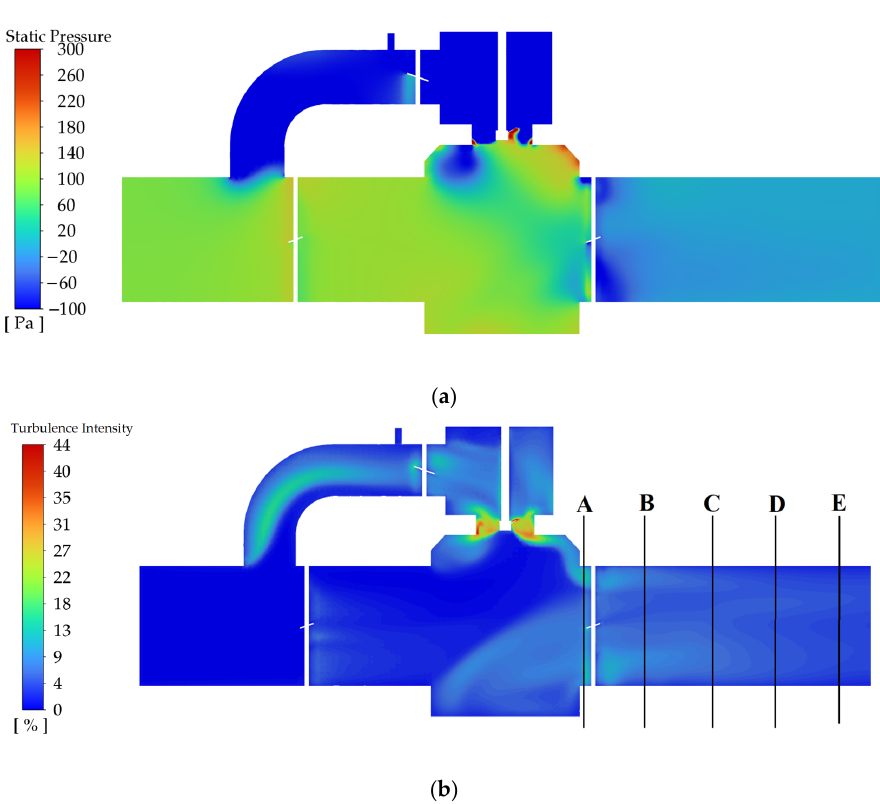
Figure 9. The contour of optimized static pressure and turbulence intensity: ( a ) contour of static pressure; ( b ) contour of turbulence intensity.